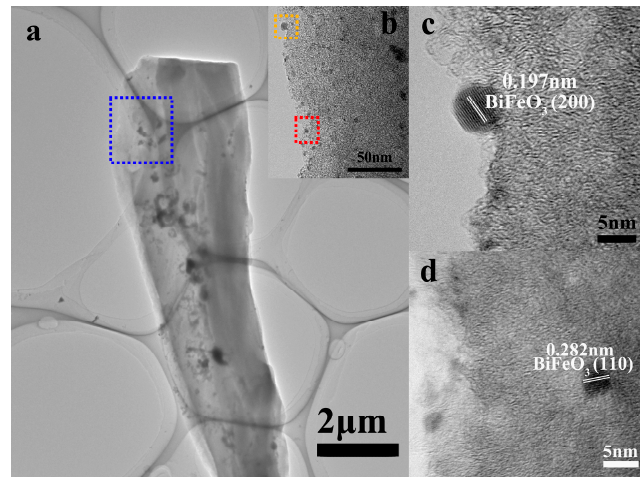
Figure 4. The TEM image ( a , b ) and high resolution transmission electron microscopy(HRTEM) images ( c , d ) of the CCT-BFO. The blue square in ( a ) is ( b ), and the orange and red square in ( b ) are corresponds to HRTEM images ( c , d ).